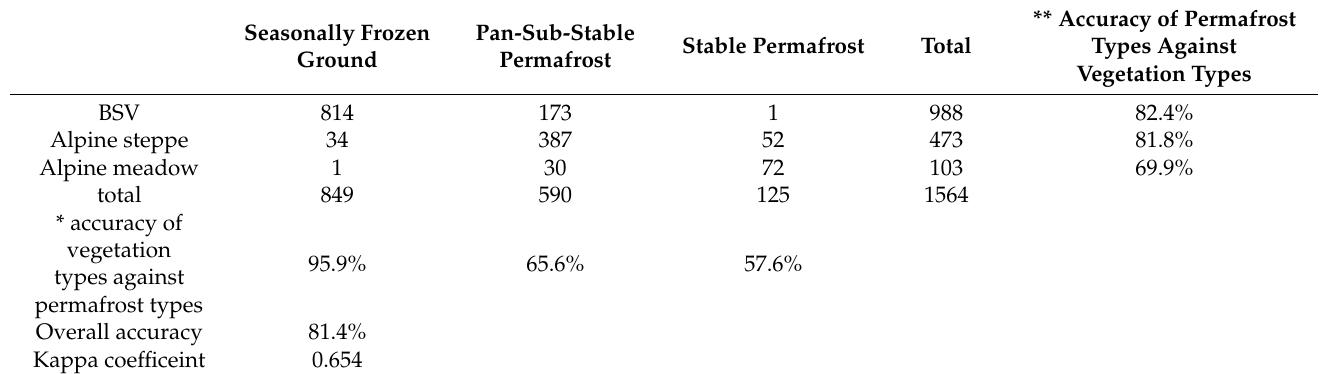
Table 7. Environmental and meteorological factors at the West Kunlun and the Gaize area.